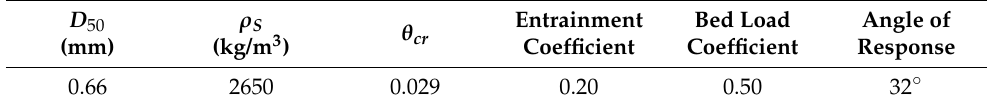
Table 2. Sediment